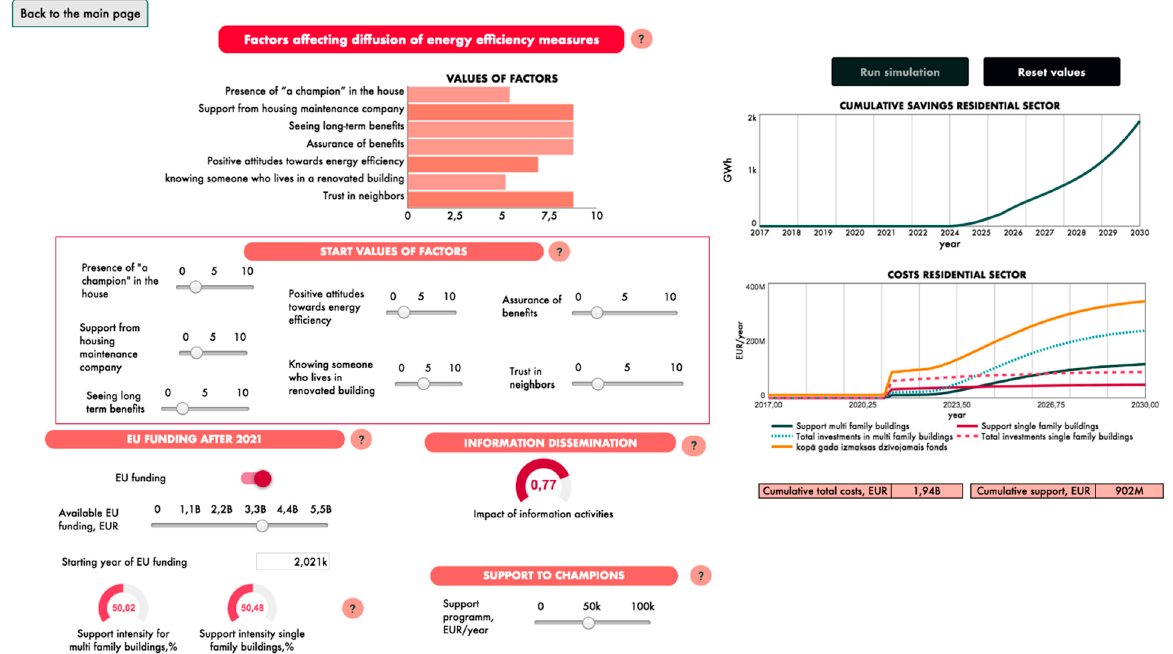
Figure 13. Interface for more in-depth analysis of apartment owner decision-making dynamics.